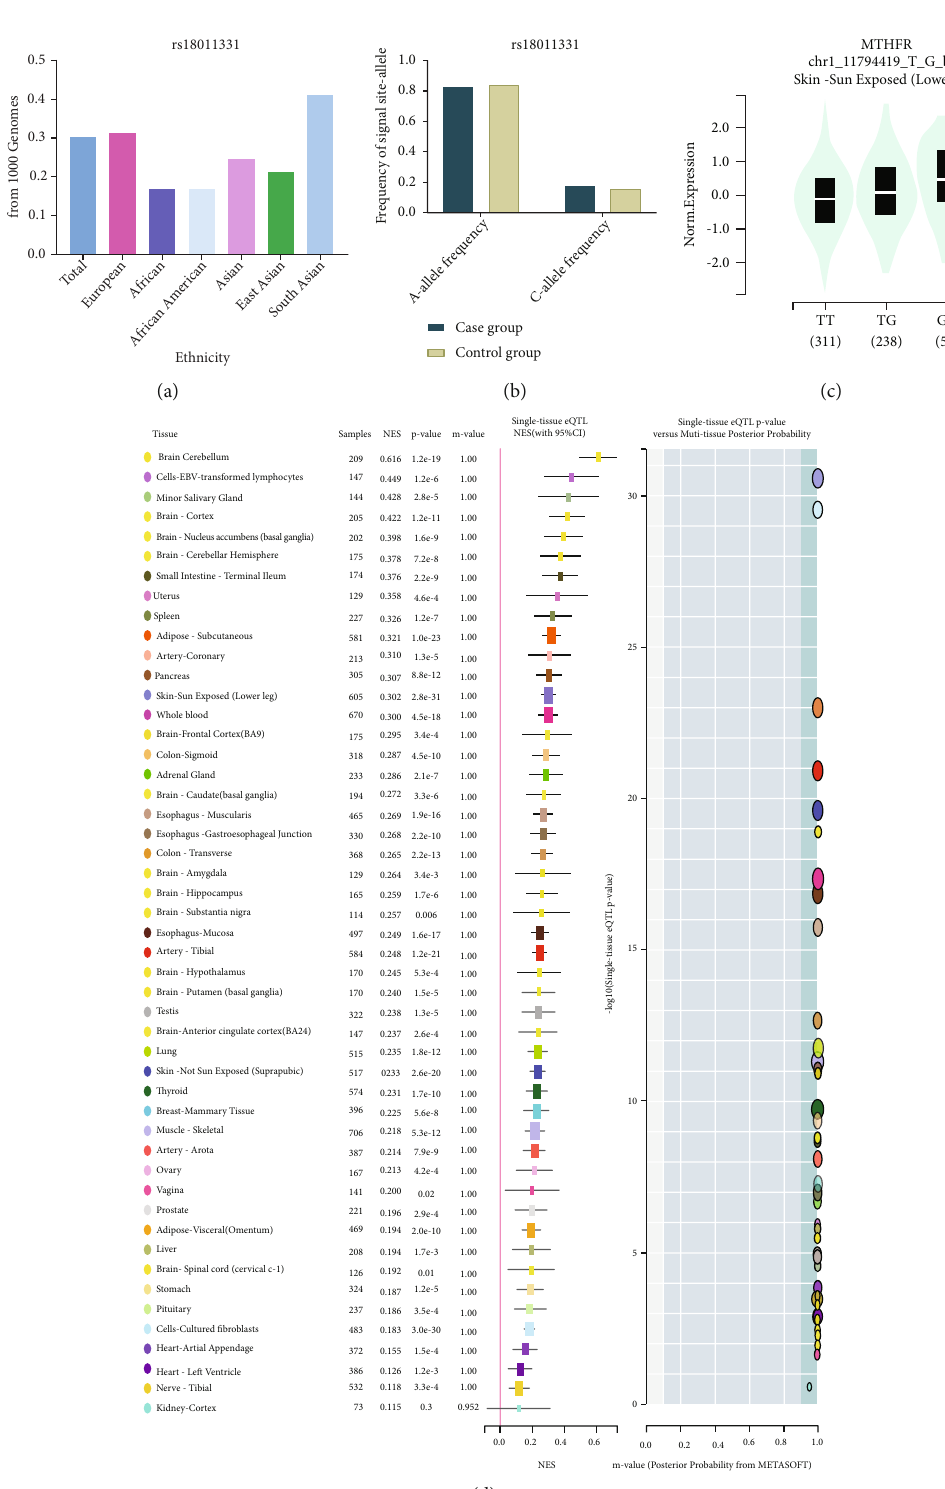
Figure 3: (a) The MAF of minor allele (mutant allele) for MTHFR gene rs1801131 polymorphism from the 1000 Genomes online database. (b) The frequency about T-allele or C-allele both in the case and control groups. (c) The distribution of each genotype from online GTEx Portal (https://www.gtexportal.org/home/). (d) The risk frequency of rs1801131 polymorphism to several diseases from TCGA